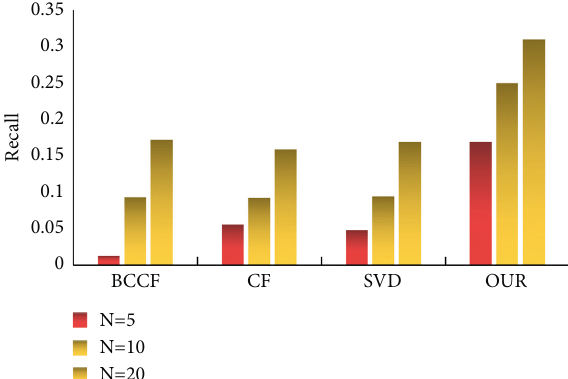
Figure 2: Comparison of recall on MovieLens 100k.